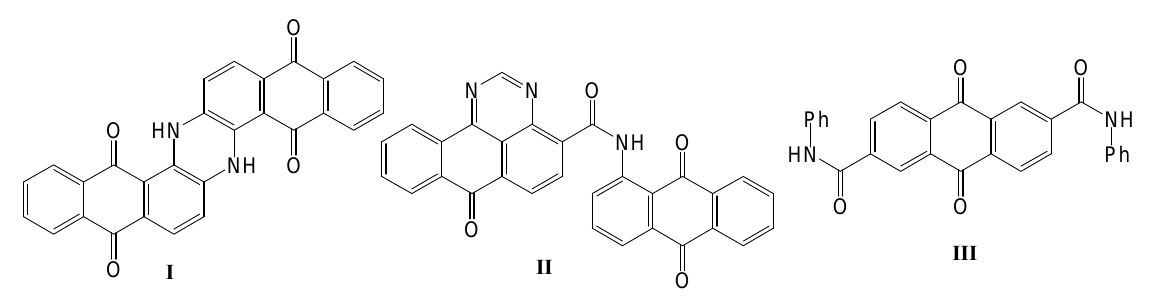
Figure 1. Some commercial vat